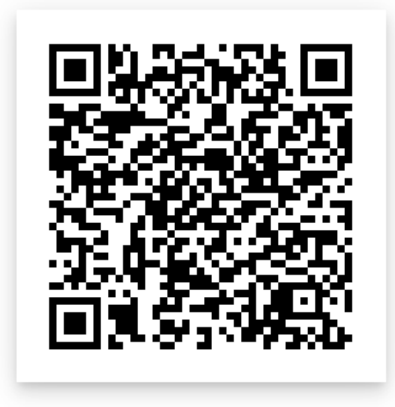
Figure 1. The Quick Response code of the electronic